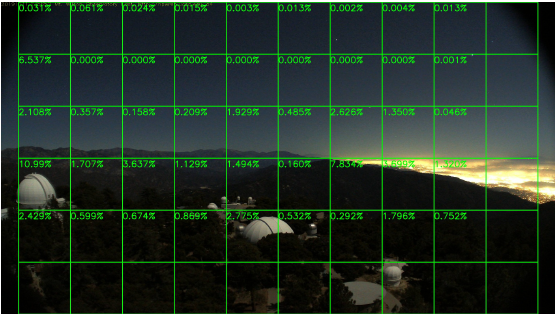
Figure 20. A HPWREN no-fire night frame, 11 November